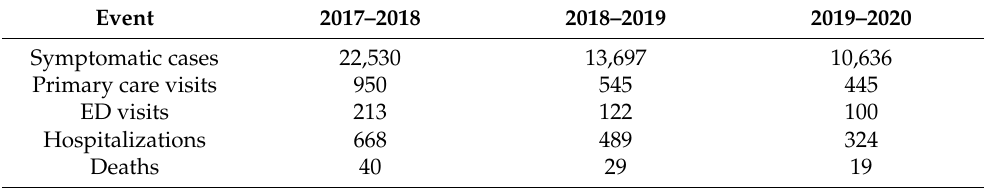
Table 1. Incidence rates of influenza ‐ related clinical events per 100,000 subjects aged ≥ 65 years. Event